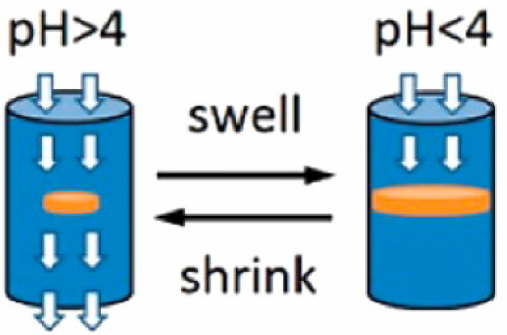
Figure 16. pH-responsive flow regulating smart valve. Reprinted from reference [110], with the permission of American Chemical Society, Copyright 2016.